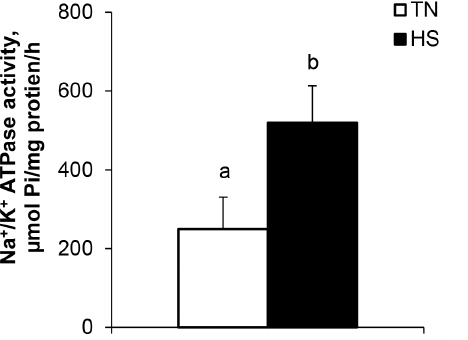
Figure 6. Heat stress conditions (HS; 35 u C) increase Na + /K + ATPase activity compared to pigs reared in thermal neutral conditions (TN; 21 u C) for 24 hours. a,b P , 0.05, n=8/trt.